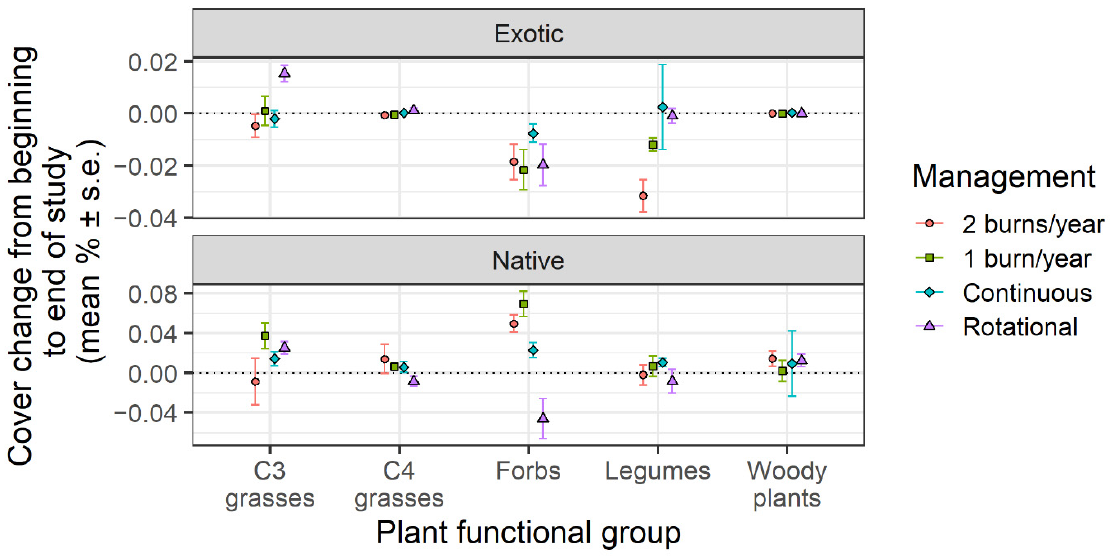
Figure 3. Changes to the cover of vegetation functional groups of native and exotic species in patch- burn treatments with one burn/year, two burns/year, continuous grazing, and modified rotational grazing systems from the beginning to the end of treatment implementation at the Central Grasslands Research Extension Center in Streeter, ND. Error bars represent one standard error.